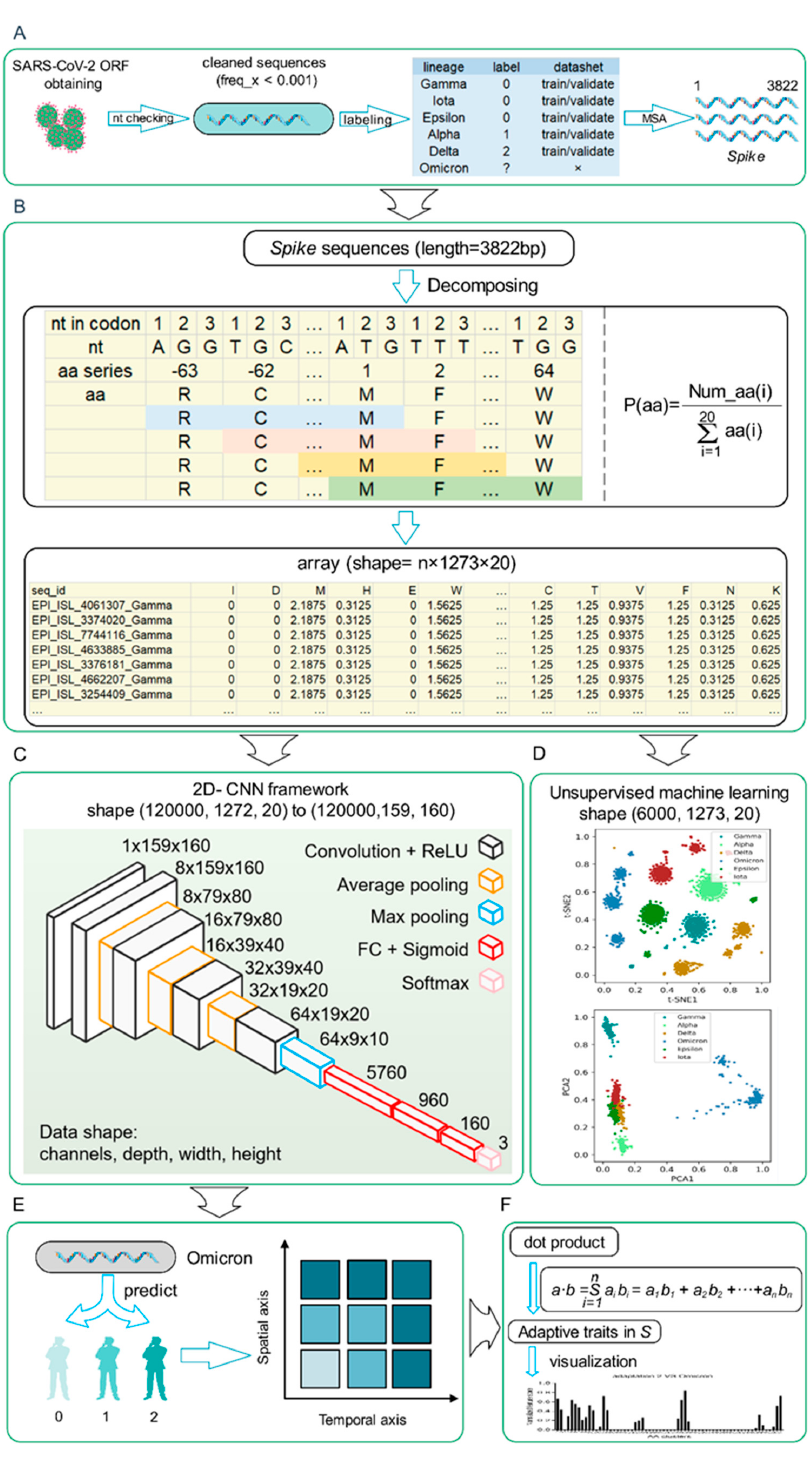
Figure 1. Workflow to decompose sequential amino acid (AA) frequency and to build the deep learning model for adaptation prediction. The workflow was designed from the top to bottom as follows: sequence cleaning and sampling of SARS-CoV-2 Spike genes ( A ), sequence decomposing diagram ( B ), design of the 2D-CNN model ( C ), unsupervised machine learning of randomly selected SARS-CoV-2 Spike genes ( D ), human adaptability prediction of Omicron variants ( E ), and the assessment of amino acid features for human adaptation ( F